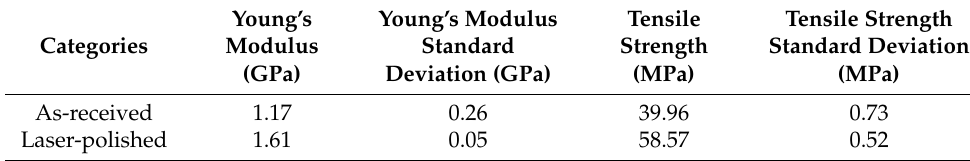
Table 6. Tensile properties and standard